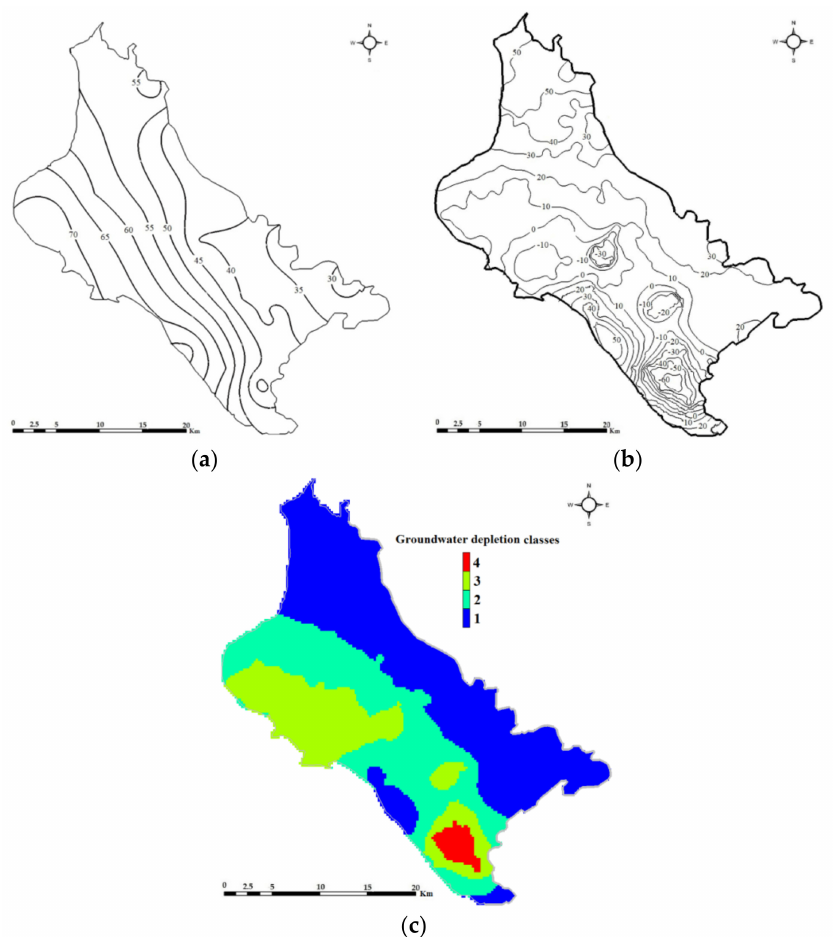
Figure 6. Maps of: ( a ) initial hydraulic heads contours of aquifer for 1987, ( b ) simulated hydraulic heads contours for April 2013, and ( c ) groundwater depletion classes of Karla watershed